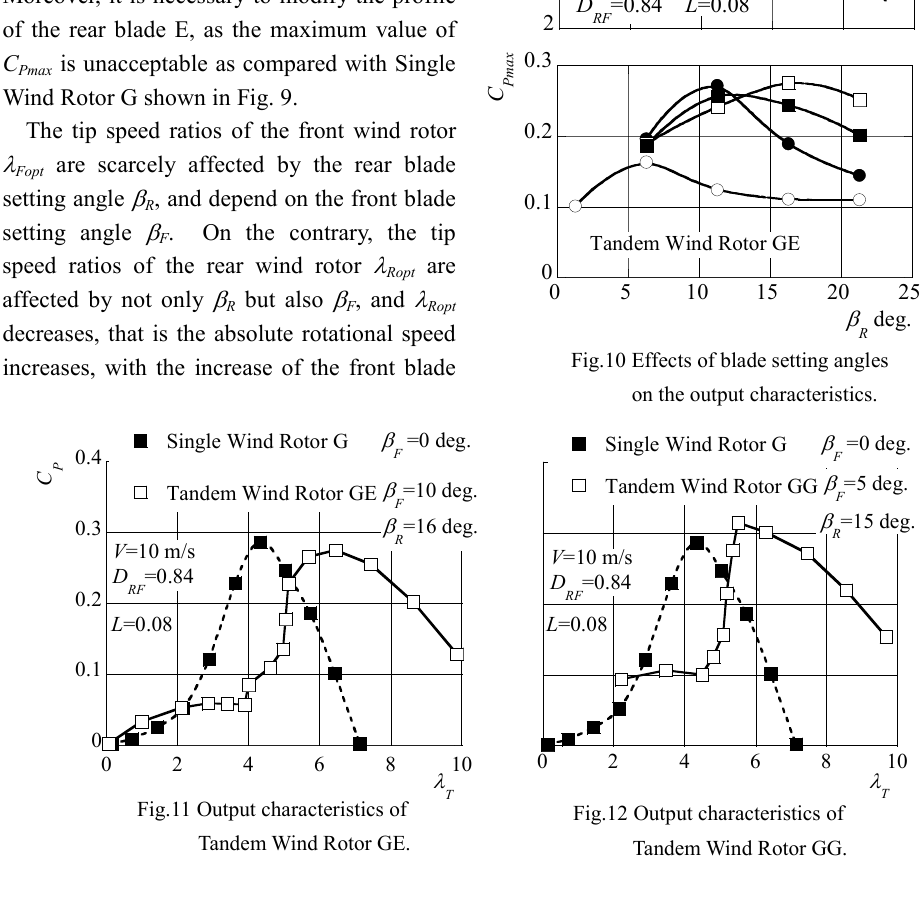
Fig.11 Output characteristics of Tandem Wind Rotor GE.